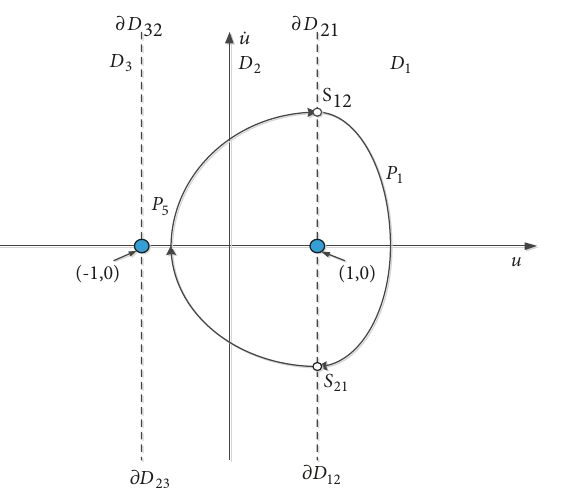
Figure 13: Double-sided impact.